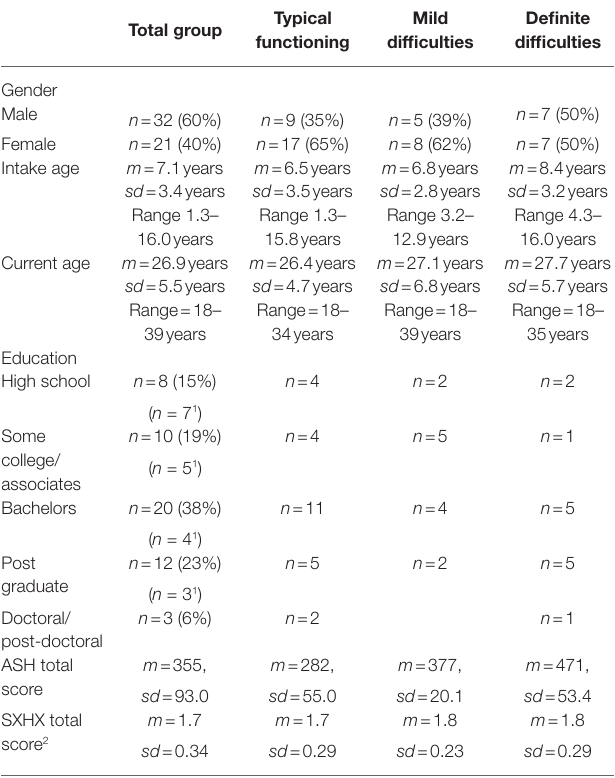
TABLE 1 | Demographics of Total adult group and ASH subgroups. Typical Mild Definite Total group functioning difficulties